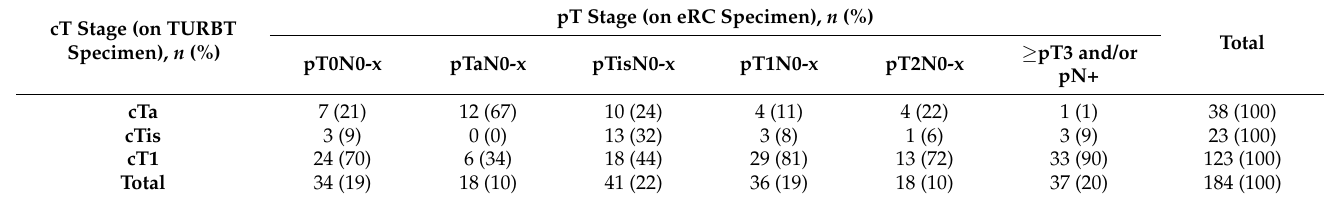
Table 4. Cross-tabulation of cT stage from TURBT and pT stage from eRC of included patients with HR-NMIBC.